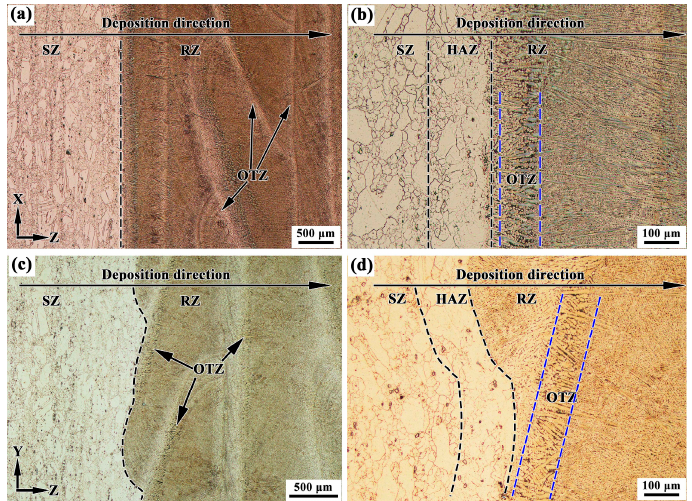
Figure 4. OM graphs in the ( a , b ) X–Z section and ( c , d ) Y–Z section of LARed Inconel 625 samples around the repaired interface.